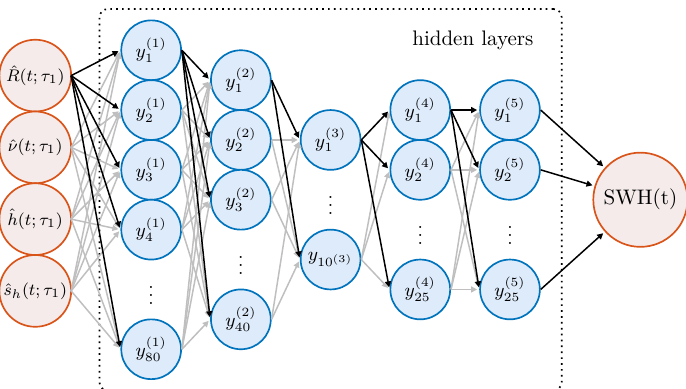
Figure 6. Depiction of the architecture of the ANN for predictor setting 4 a . The neurons of the hidden layers are colored in blue. Input and output layer are displayed in red. Predictor information is passed from left to right through the network, as symbolized by the